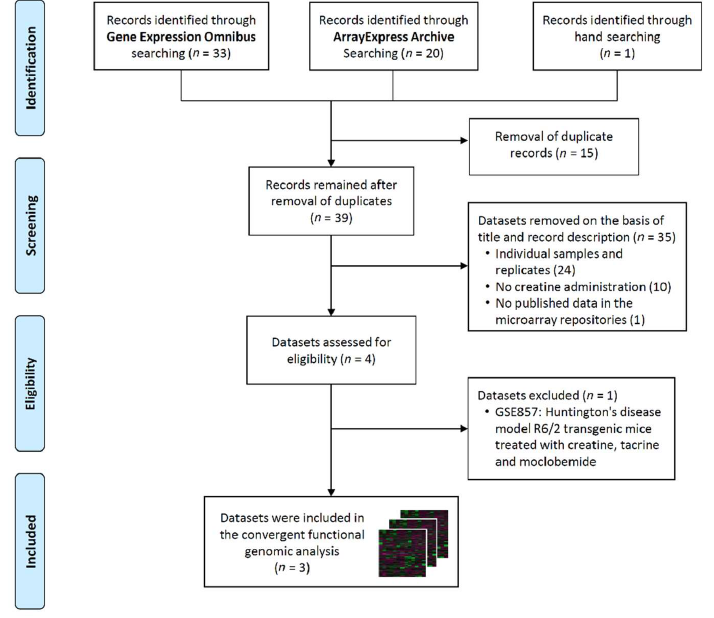
Figure 1. PRISMA flow diagram.